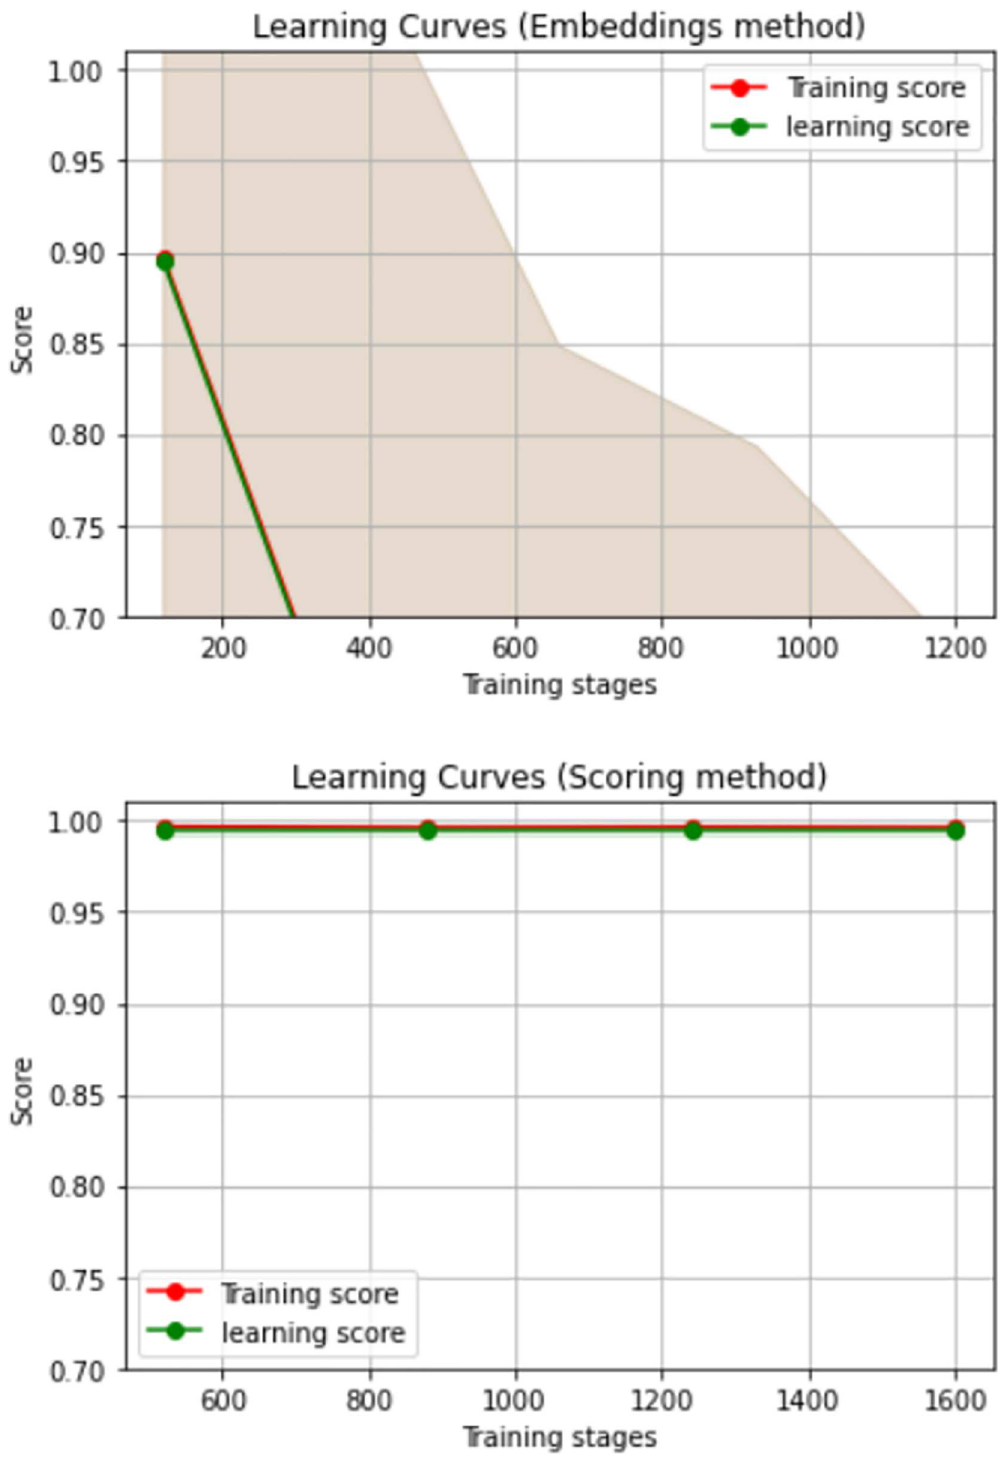
Fig 34. Learning improvements with embedding then scoring